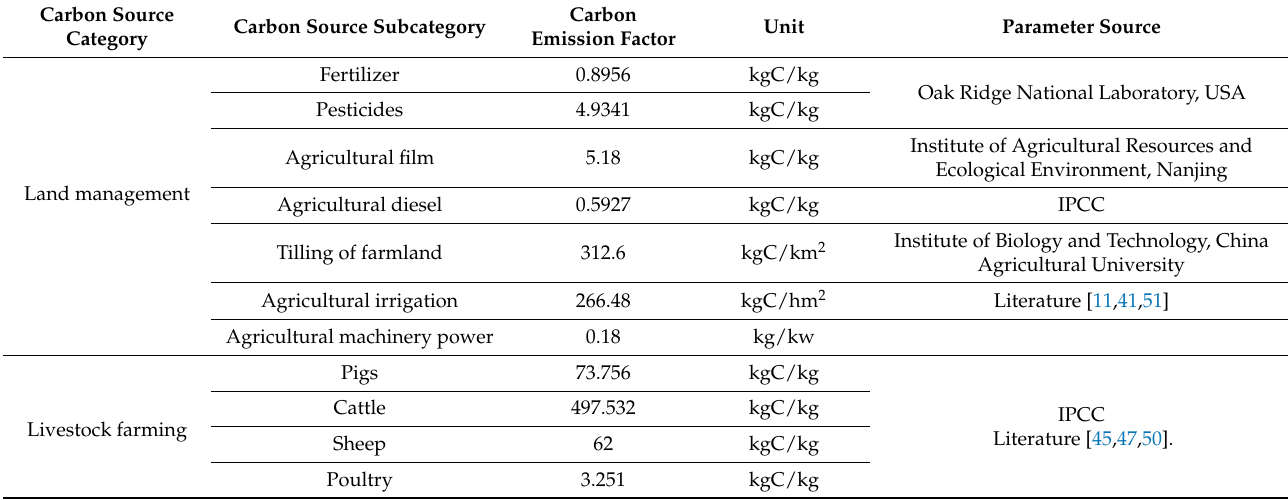
Table 2. Carbon emission factors of carbon emission